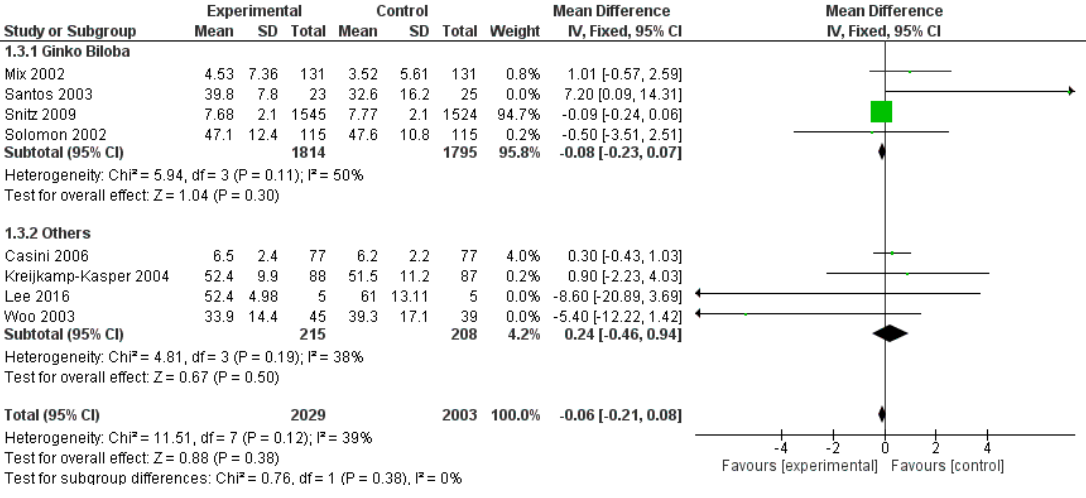
Figure 10. Pooled analysis of the impact of polyphenols on Wechsler Adult Intelligence Scale (WAIS) Digital symbol field.